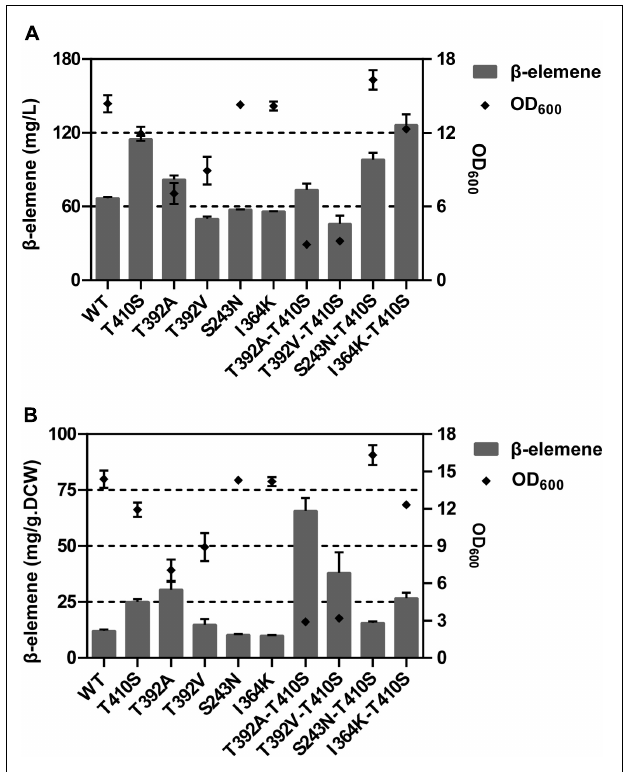
FIGURE 7 | The titer (A) and per-cell productivity (B) of β -elemene in E. coli BL21 Star (DE3) pMM – LTC2 mutants.